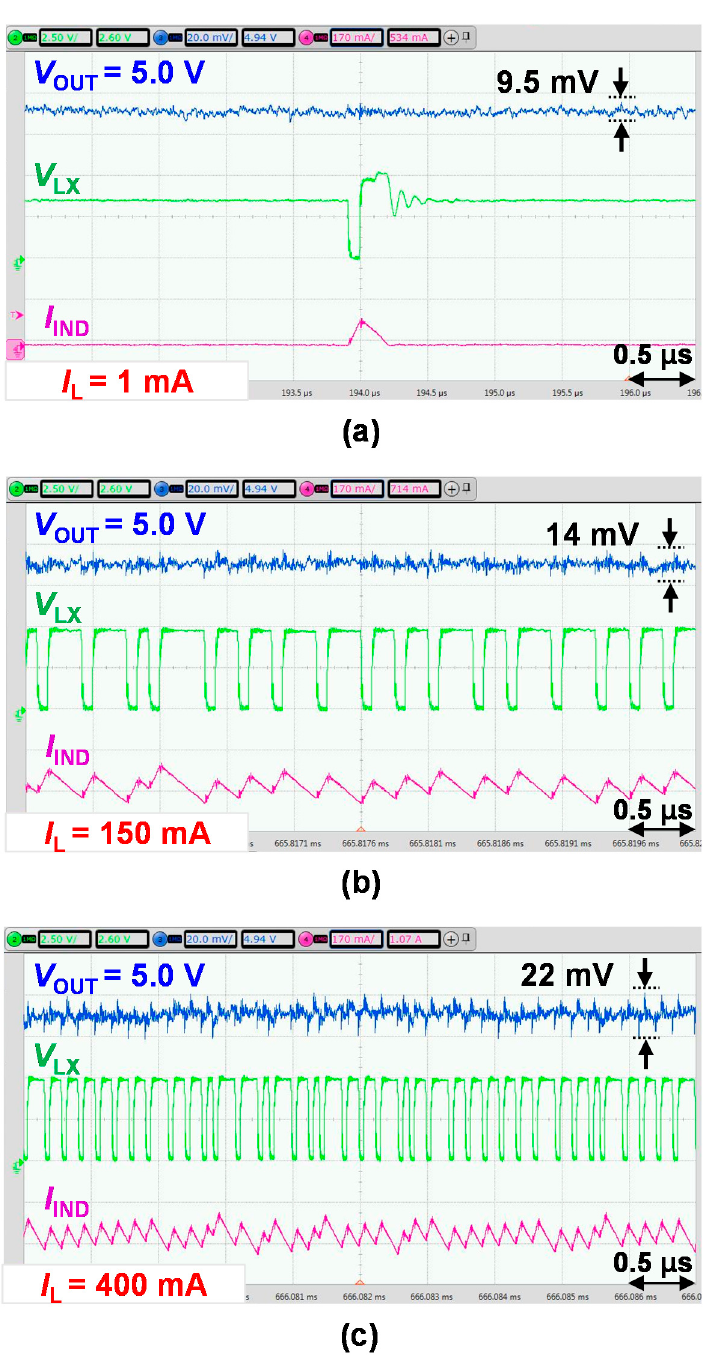
Figure 12. Measured transient waveforms with respect to the load current at V IN = 3.7 V. ( a ) I L = 1 mA. ( b ) I L = 150 mA. ( c ) I L = 400